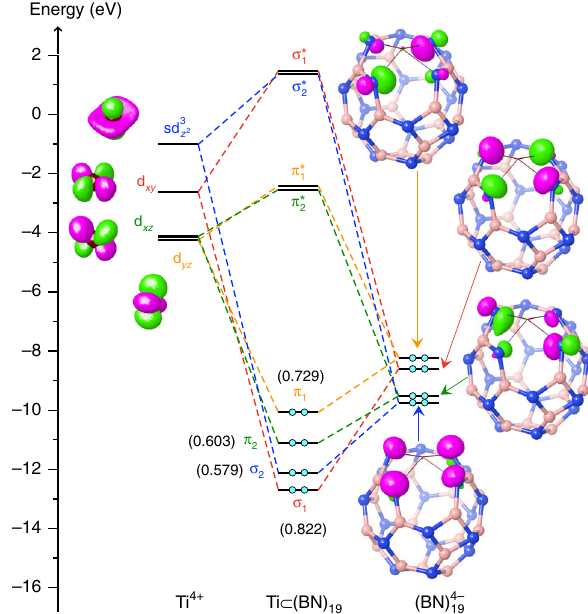
Fig. 3 Orbital correlation diagram unraveling the nature of the metal-cage bonding in Ti (cid:1) 2 . The analysis is based on the maximum bonding fragment orbital approach 35,36 . Each of the Ti ’ s atomic orbitals (left panel) is paired up with one of the cage ’ s fragment orbitals (right panel), leading to a pair of bonding and anti-bonding orbitals of the complex (middle panel). The energy levels of the associated fragment orbitals and complex orbitals are connected by dashed lines in the same color. Electrons are shown by cyan fi lled circles. Orbital surfaces are depicted using an isovalue of 0.10. The Wiberg bond orders 37 in parentheses indicate that all these four bonding interactions are essentially covalent. According to the aufbau principle 35 , this orbital diagram suggests an oxidation state of + 4 for Ti